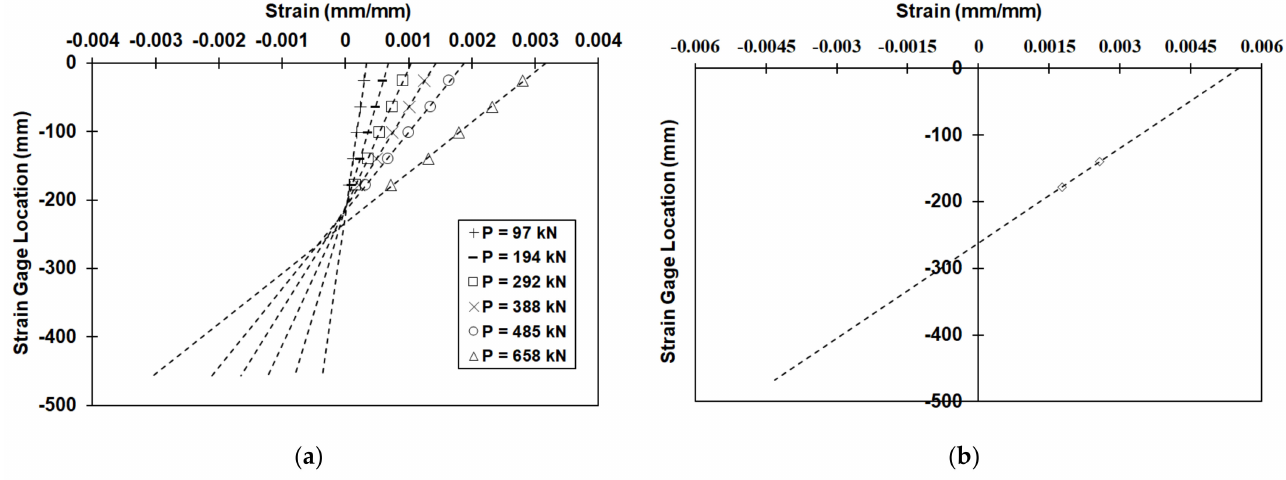
Figure 16. ( a ) Strain distribution profiles across the depth for control beam at various loads, P, based on measurements from strain gages, and ( b ) strain distribution profile for tube beam across the depth at load causing crashing of confined concrete (post-peak load 567 kN), based on available strain